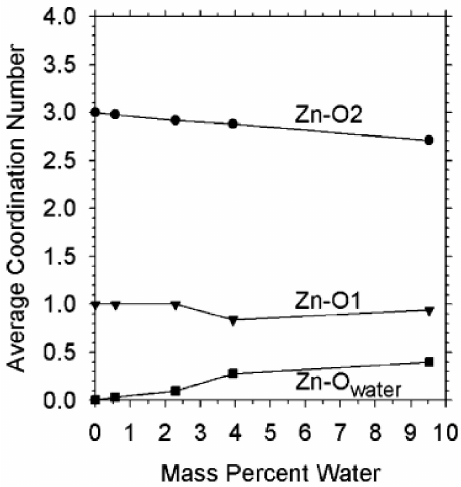
Figure 15. Zn coordination behavior upon water adsorption. Zn retains tetrahedral coordination, but the relative amounts of BDC oxygen (O2) and inorganic oxygen (O1) decrease as they are replaced by water oxygen atoms